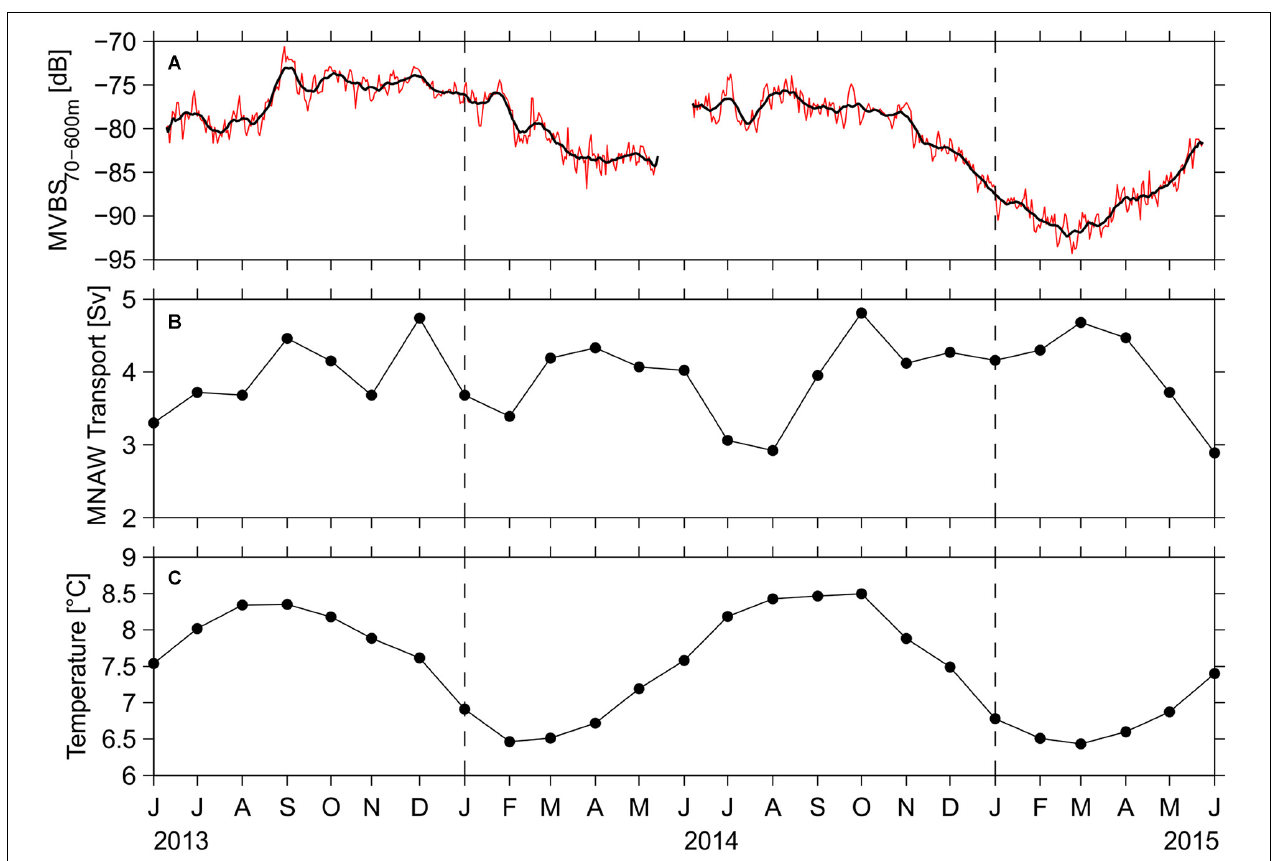
FIGURE 8 | Seasonal variability in mean volume backscattering strength and related environmental parameters: (A) depth-averaged (70–600 m) mean volume backscattering strength (daily averages as red line and 7 days running mean as black line), (B) monthly averaged transports of Modified North Atlantic Water (MNAW) in the Faroe Current, (C) monthly transport-averaged temperature of the MNAW (Hansen et al.,